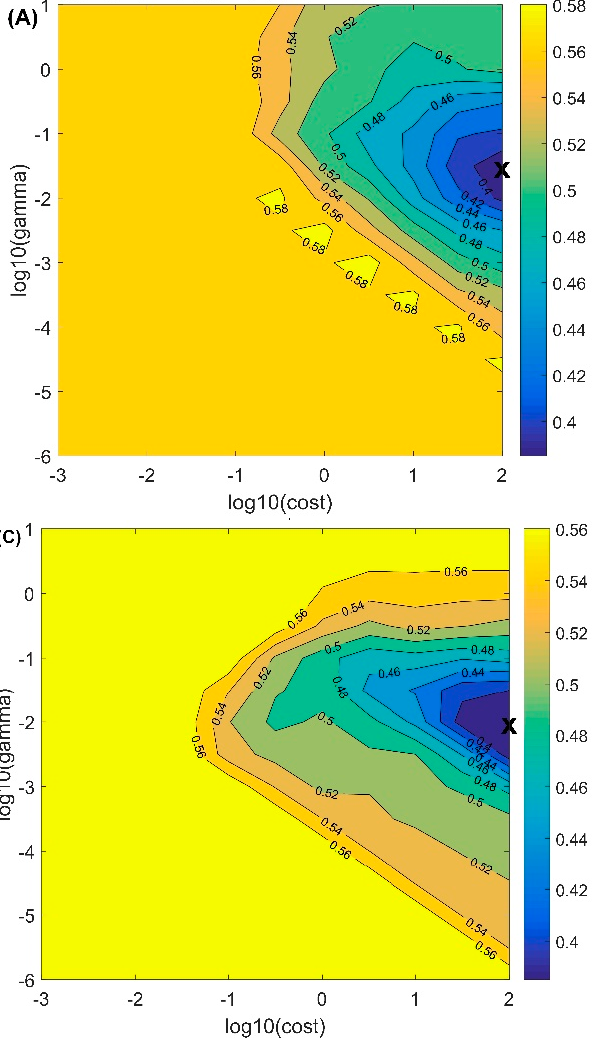
a ( A ), µ s ’ ( B ), µ a × µ s ’ ( C ), and